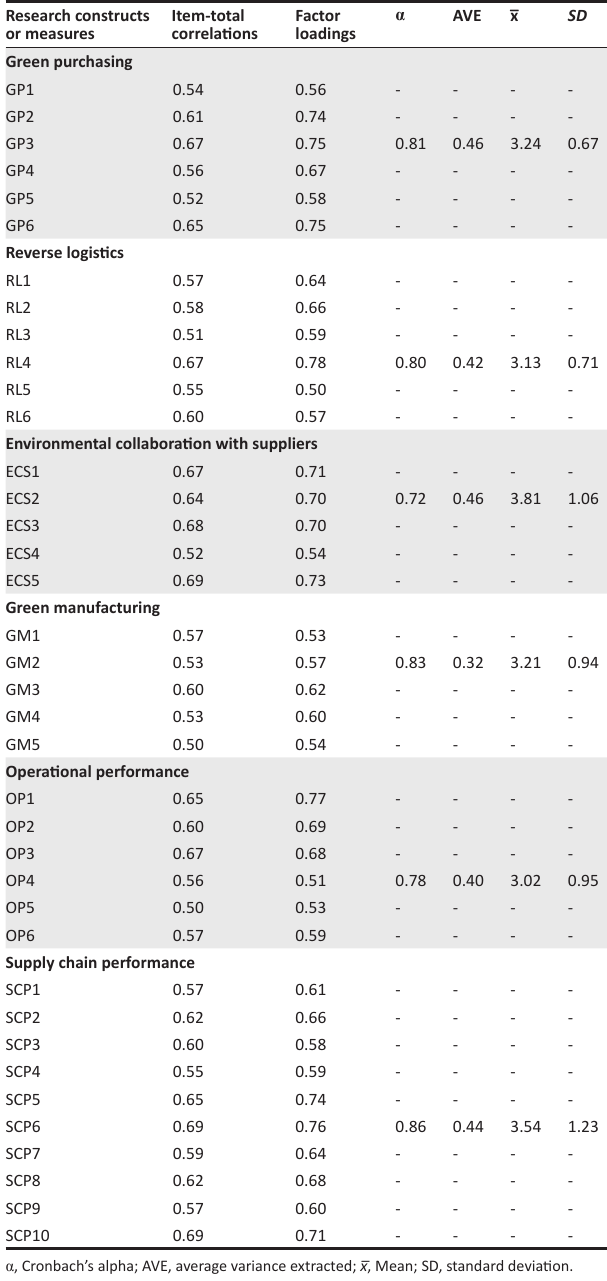
TABLE 1: Psychometric properties of measurement